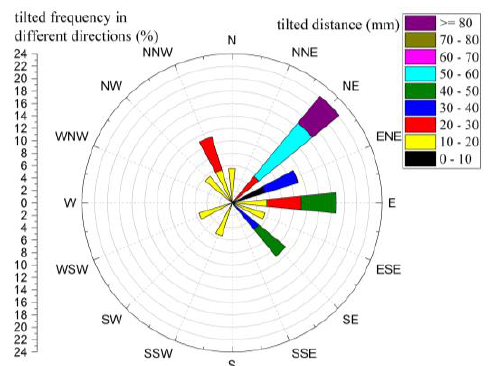
Figure 8. A wind rose graph of the columns on the first floor